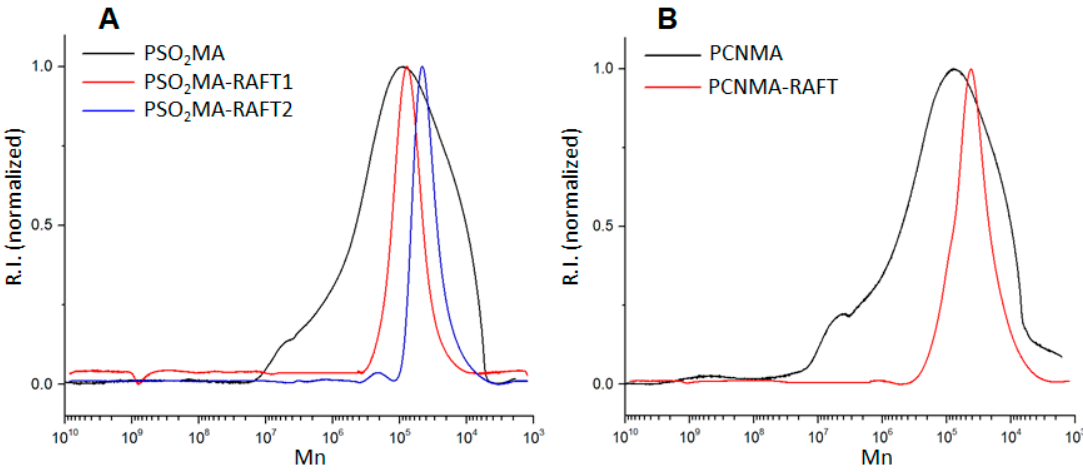
Figure 3. Size-exclusion chromatography (SEC) traces obtained for PSO 2 MA ( A ) and PCNMA ( B ) polymerized by both methodologies.